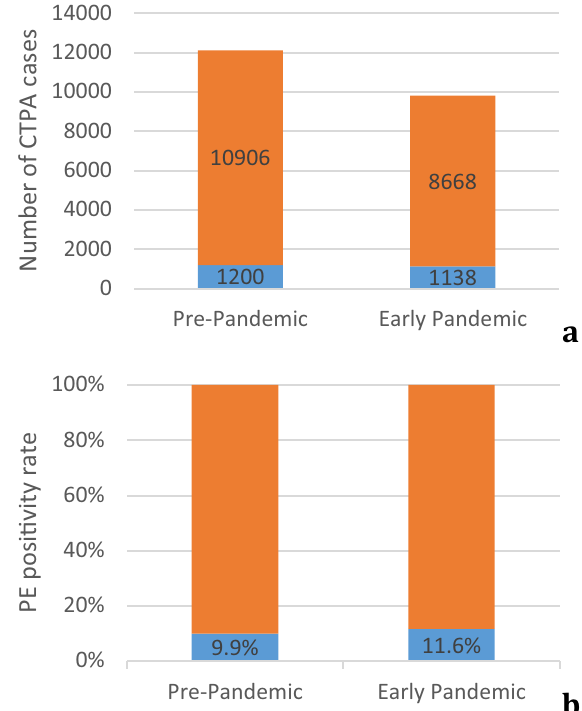
Fig. 2 Total acquired CTPA scans and PE positivity rates. Total numbers of acquired CTPA scans ( a ) during the two observation periods demonstrate a clear decrease in the total number of studies performed. Simultaneously, the prevalence of positive PE cases (blue bar) increased in the early COVID-19 period ( b ). For a detailed account of institution-speci fi c data, please see Supplementary Fig. 3 of the Supplemental Material.